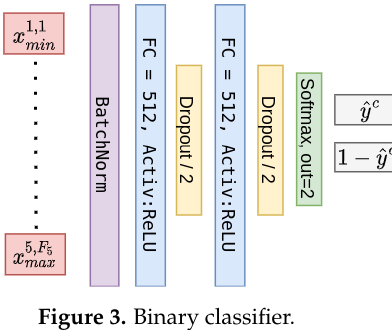
Figure 3. Binary